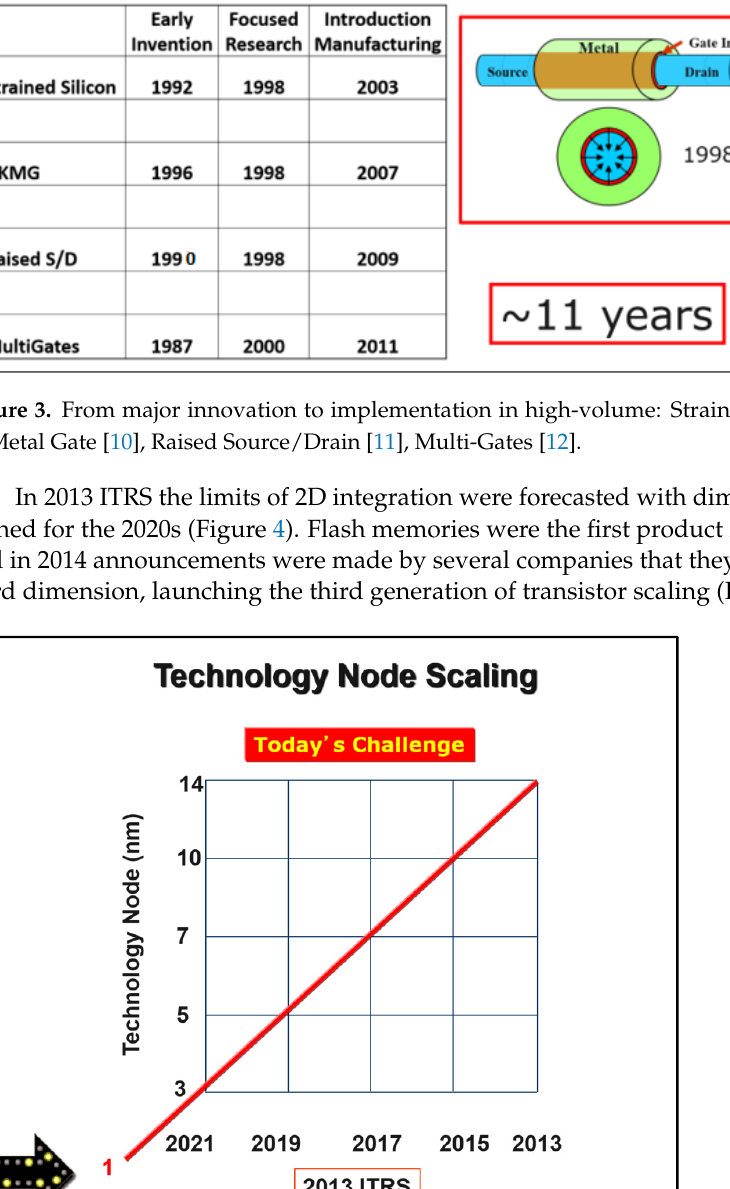
Figure 4. The past extrapolation showing that 2D scaling faced fundamental limits beyond 2020.